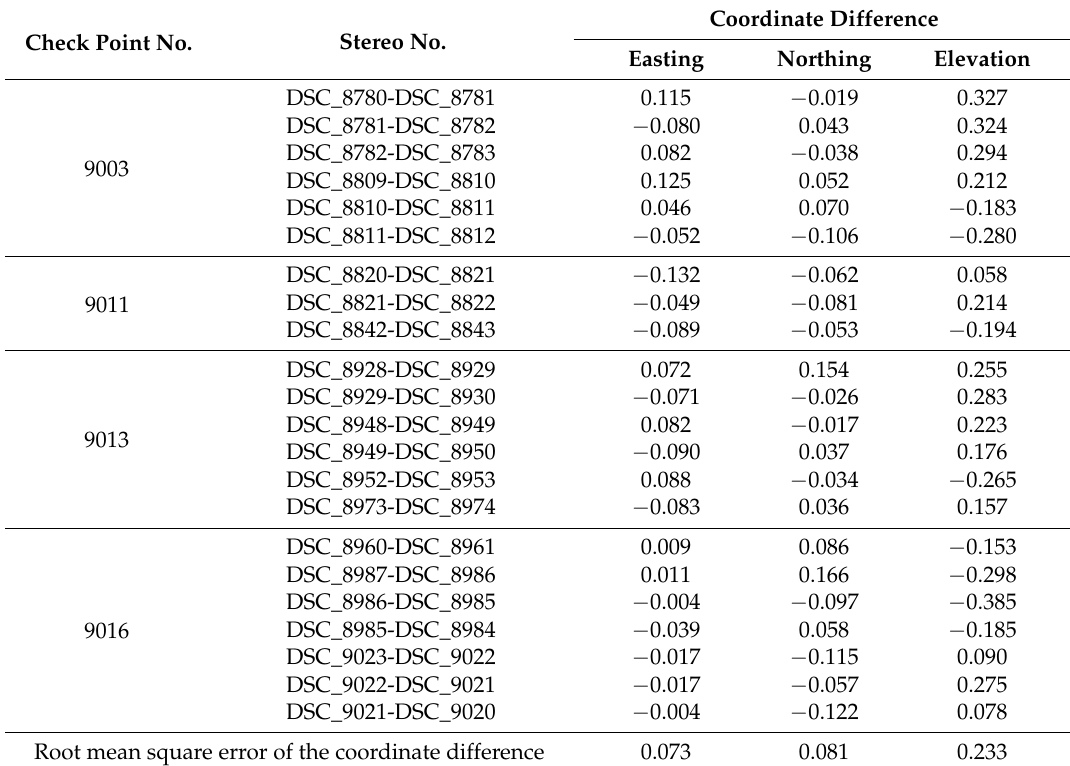
Table 1. The coordinate differences of check points from in-strip stereo image pair (unit: m). Check Point No. Stereo No.